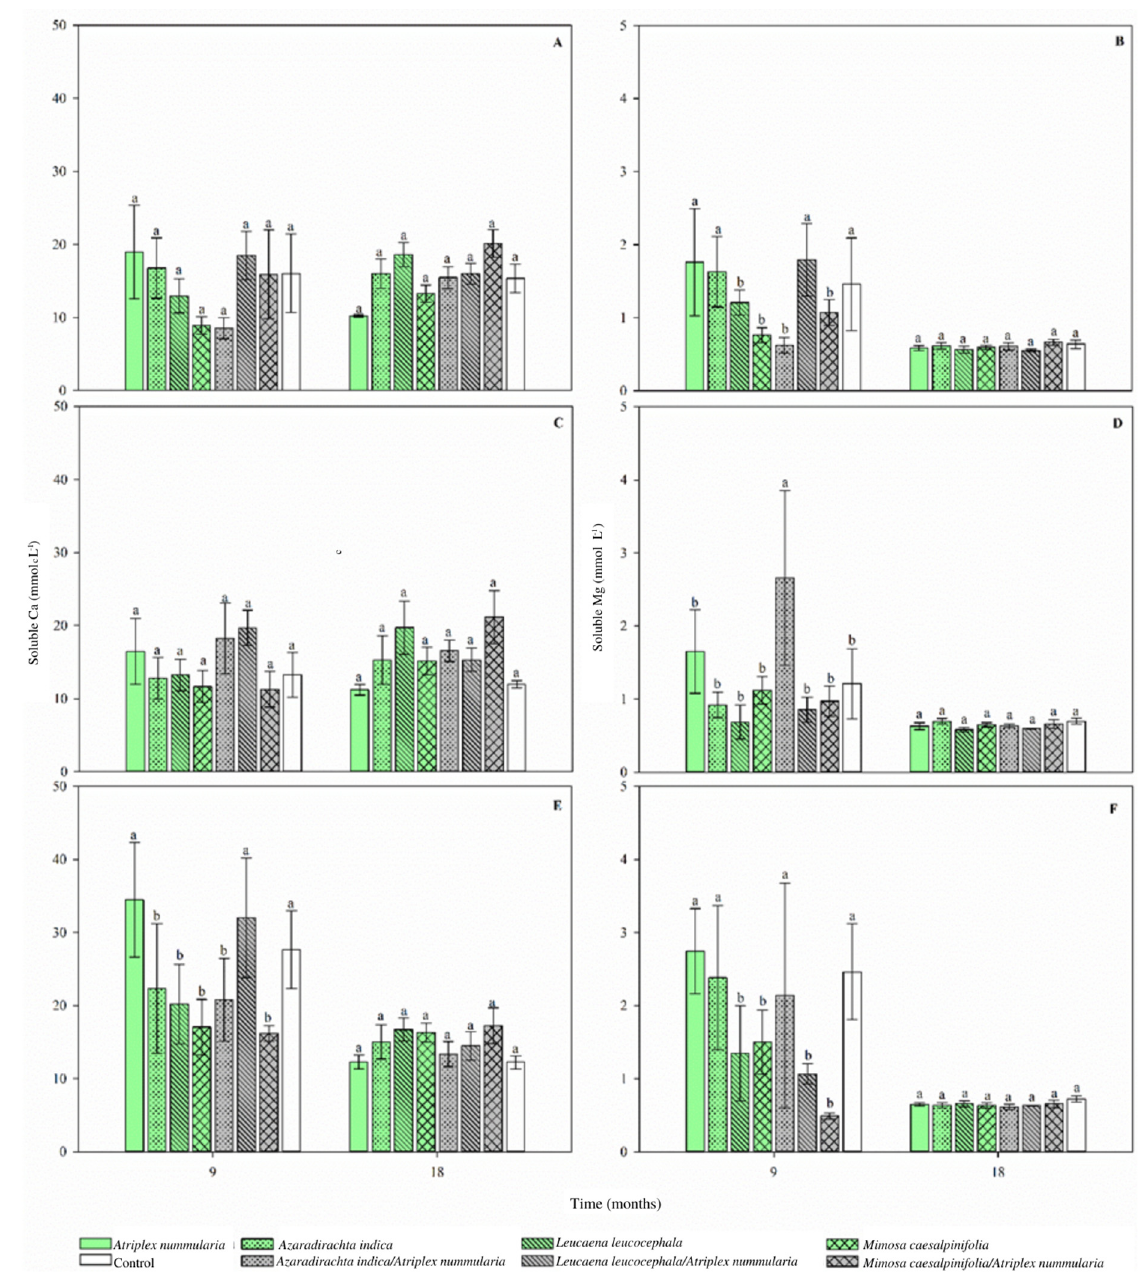
Figure 5. Soluble Ca 2+ [( A ) 0–10 cm; ( C ) 10–30 cm; ( E ) 30–60 cm] and soluble Mg 2+ [( B ) 0–10 cm; ( D ) 10–30 cm; ( F ) 30–60 cm] at 9 and 18 months as result of the applied treatments. treatments (Averages of four replications). Averages followed by the same letter have no difference in the same layer and time of sampling by the Skott-Knott test ( p ≤ 0.05).